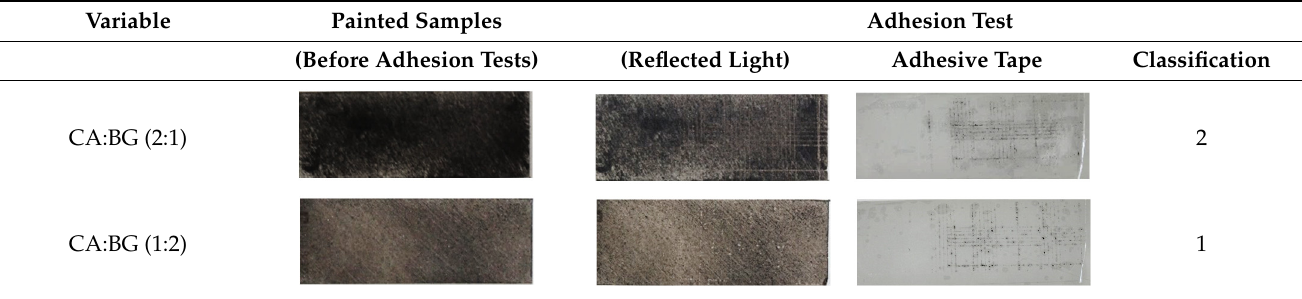
Table 6. Cont . Variable Painted Samples